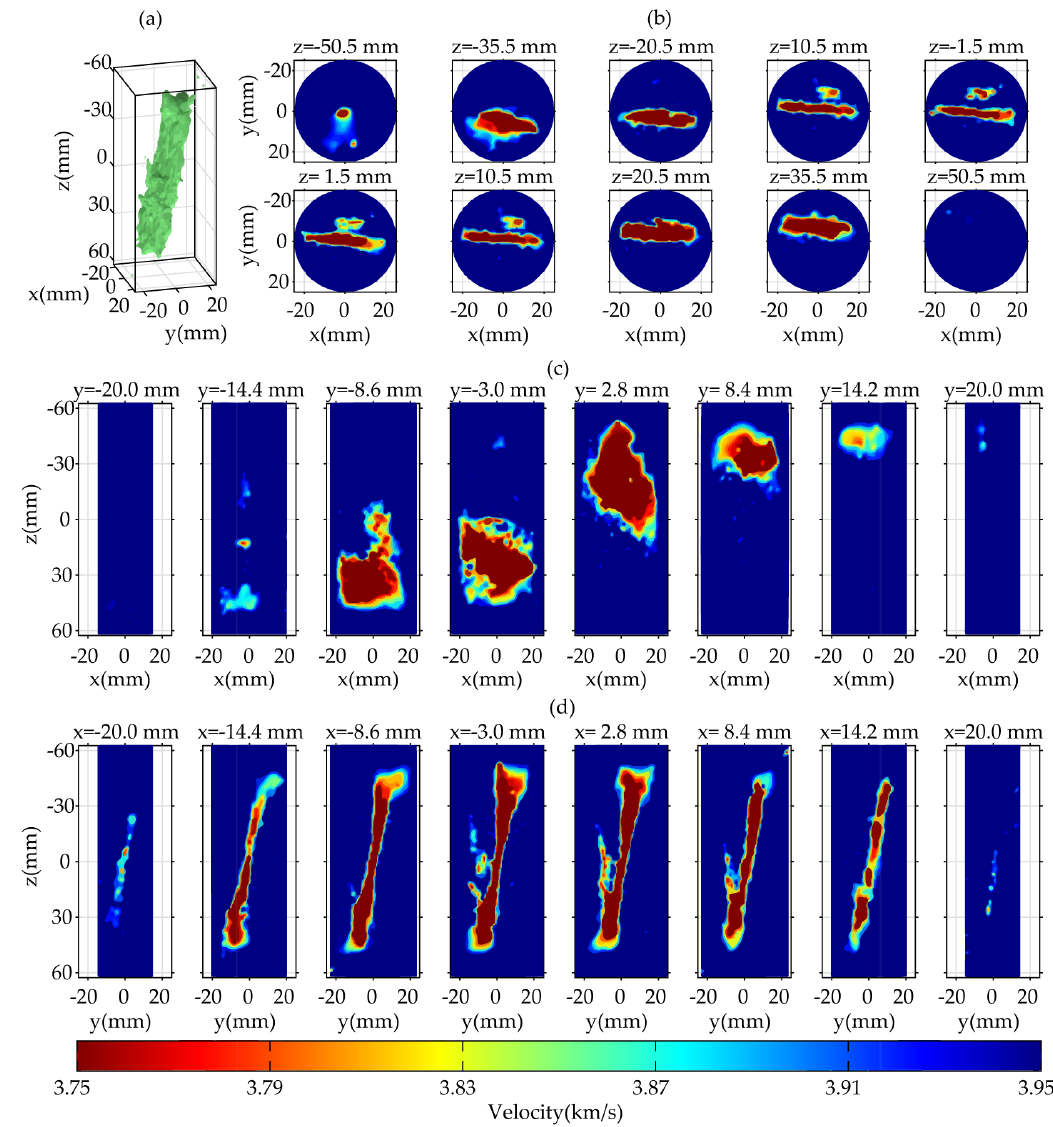
Figure 11. Tomographic images of TVR under dense ray-coverage case. ( a ) the 3D segmented image; ( b ) the transverse-view profile; ( c ) the coronal-view profile; and ( d ) the sagittal-view profile. The caption of each sub-image in ( b – d ) represents the profile position.